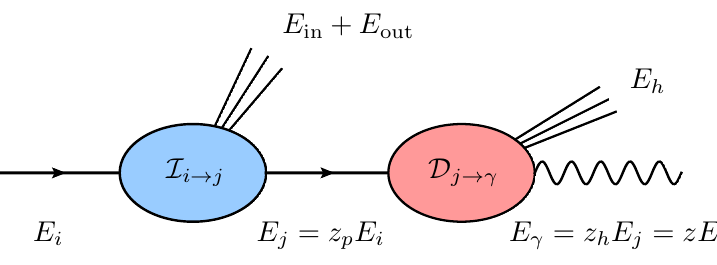
Figure 3 . Kinematics of the factorization (2.8) of the cone fragmentation function F i → γ into a perturbative and non-perturbative part. The radiated partons in the perturbative part I i → j can be inside or outside the isolation cone, while the non-perturbative radiation in D j → γ is always inside. The perturbative momentum fraction is z p = z/z h